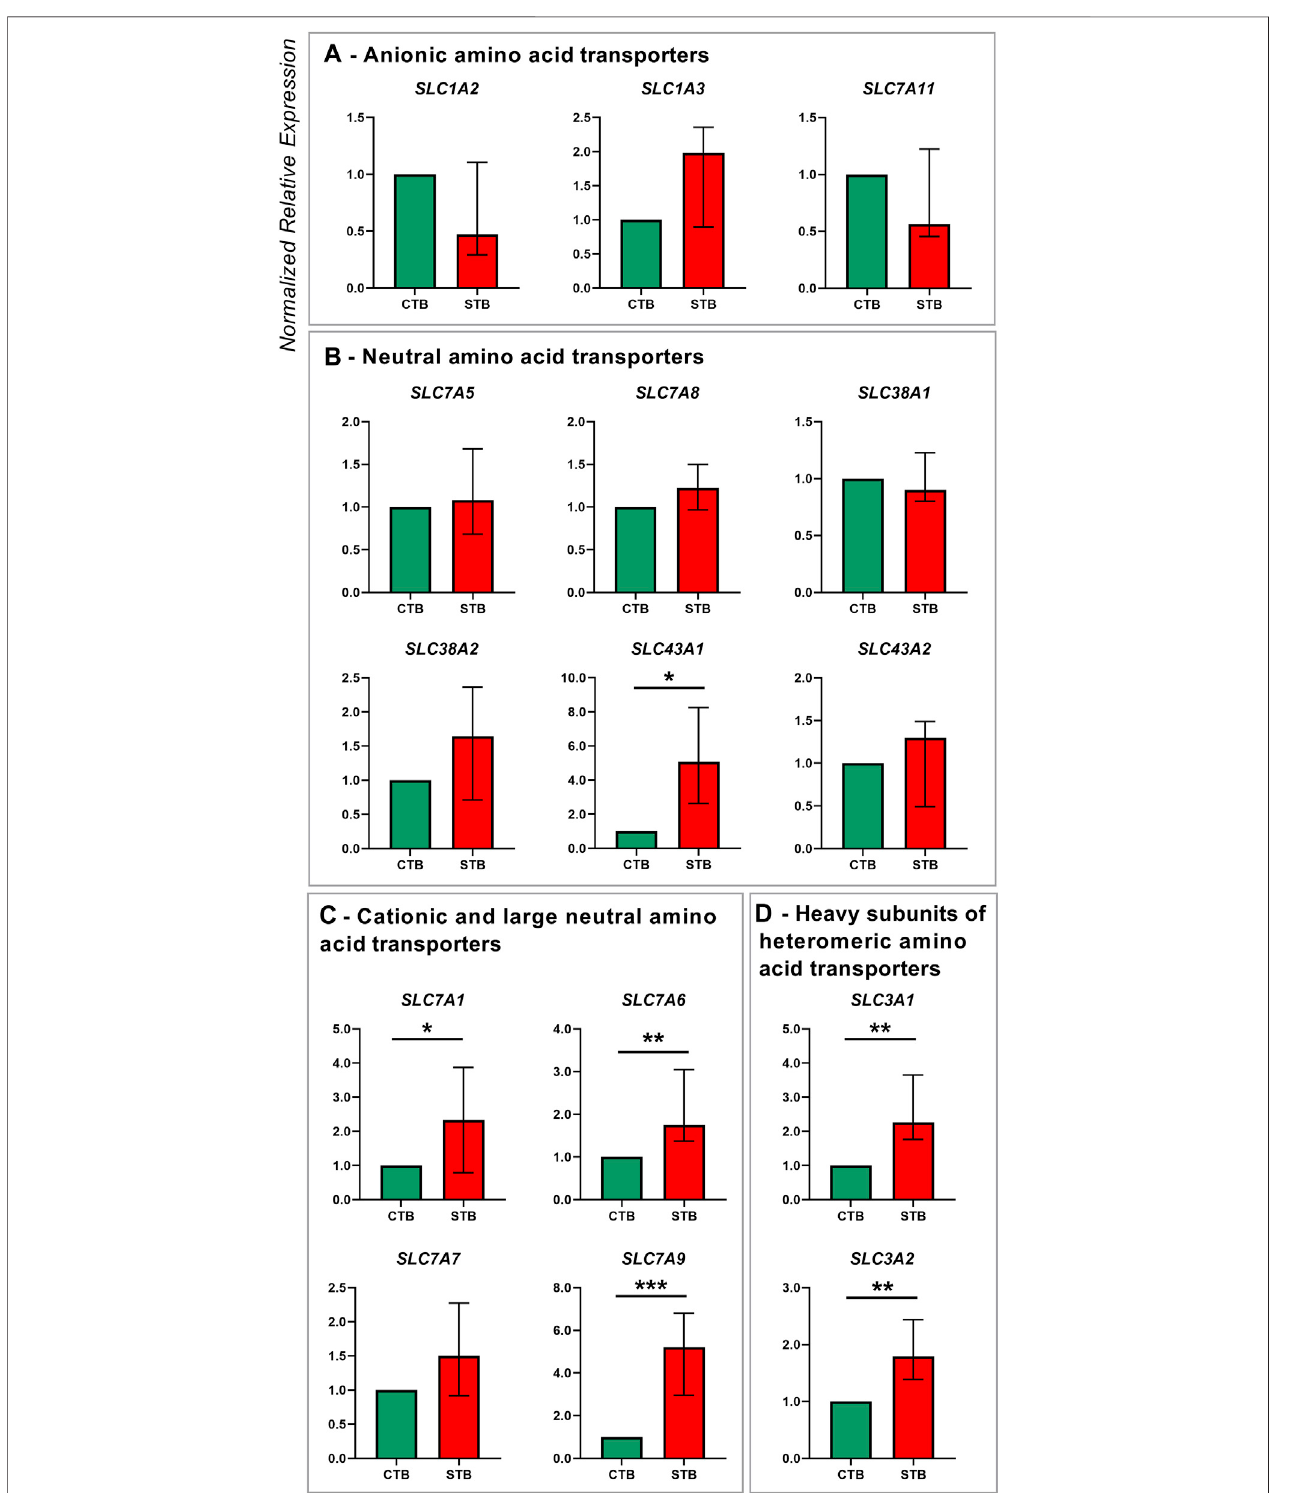
FIGURE2| AminoacidtransportergeneexpressioninhumantermprimaryCTBsanduponspontaneousdifferentiationtoSTB invitro .Classi fi cationofaminoacid transporters was based on the substrate speci fi city: anionic (A) , neutral (B) , cationic and large neutral (C) , and heavy subunits of the heterodimeric amino acid transporters (D) . Target gene expression was normalized to the reference gene YWHAZ and the results are shown as median with IQR expression in differentiated cells relative to the undifferentiated counterpart; n ≥ 7 for each stage. Statistical signi fi cance was evaluated using nonparametric t -tests (Mann-Whitney test): * p ≤ 0.05, ** p ≤ 0.01, *** p ≤ 0.001.